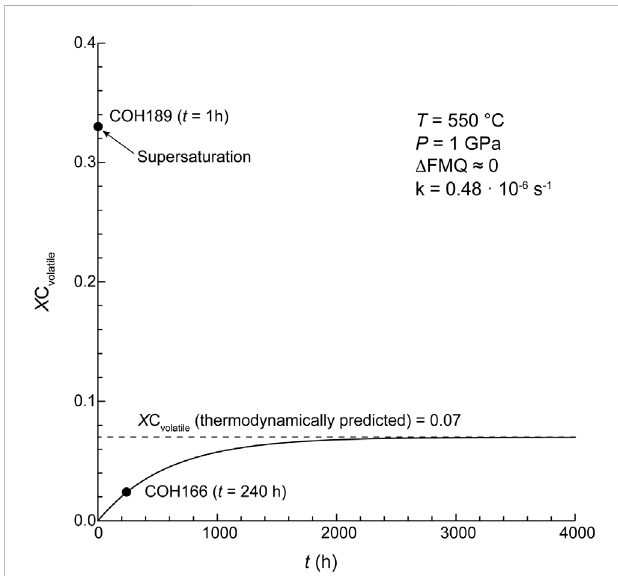
FIGURE 5 Progresscurveofgraphite dissolution (at550 ° C,1 GPaand Δ FMQ ≈ 0). A rate constant, k, of .48 10 – 6 s − 1 was chosen to fi t both experimental (COH166) and equilibrium (thermodynamically predicted; dashed line) volatile carbon mole fractions in the fl uid ( X C volatile = (CO + CO 2 + CH 4 )/(CO + CO 2 + CH 4 + H 2 O)). Equilibrium X C volatile is reached at t > 3,600 h. A supersaturation in dissolved volatile carbon species is observed in the 1 h experimental run